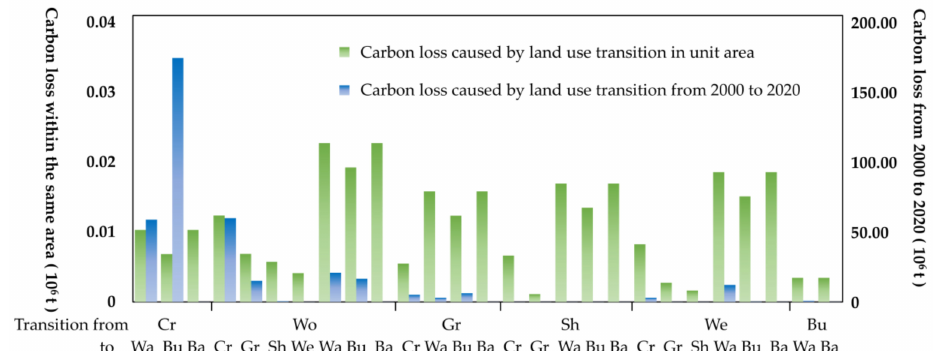
Figure 3. Carbon storage loss caused by land use change. Cr: cropland; Wo: woodland; Gr: grassland; Sh: shrubland; We: wetland; Bu: built-up land; Wa: water; Ba: bare